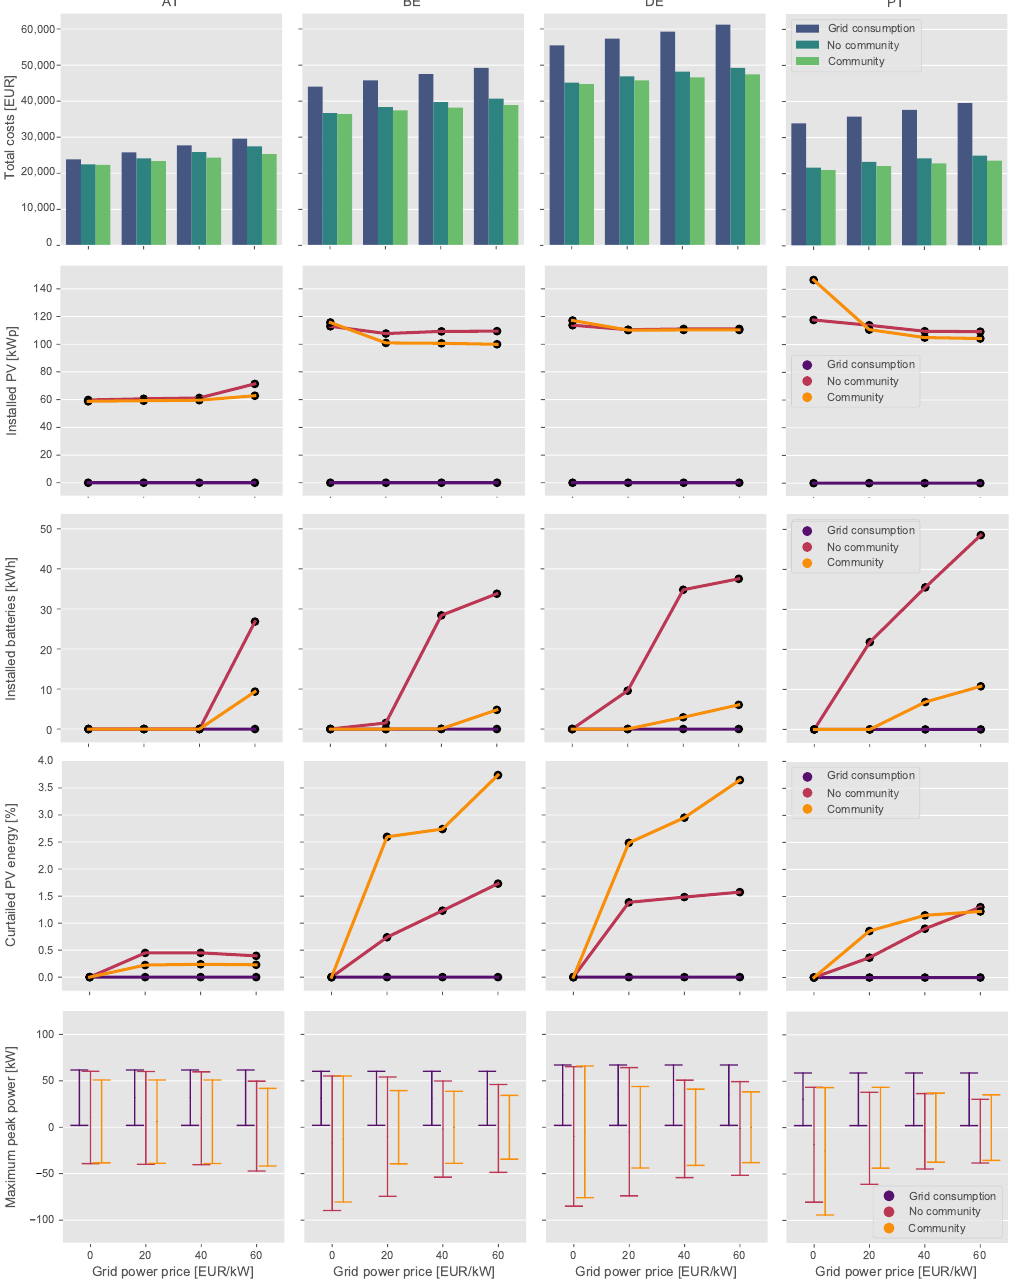
Figure 11. Variation of power prices for the future scenario for Austria, Belgium, Germany and